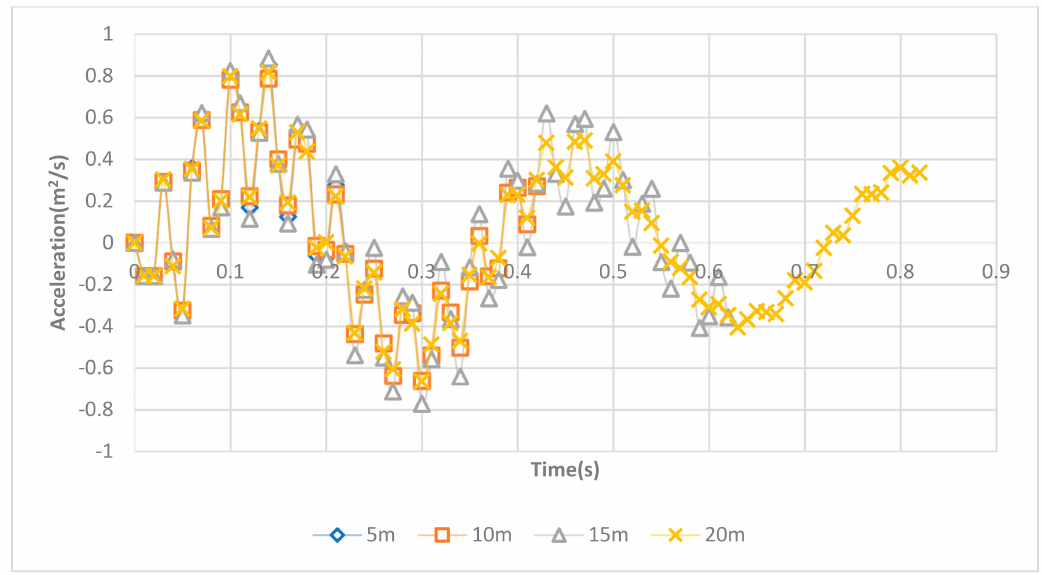
Figure 22. Right front axle acceleration history when approaching the bridge at 25 m/s.